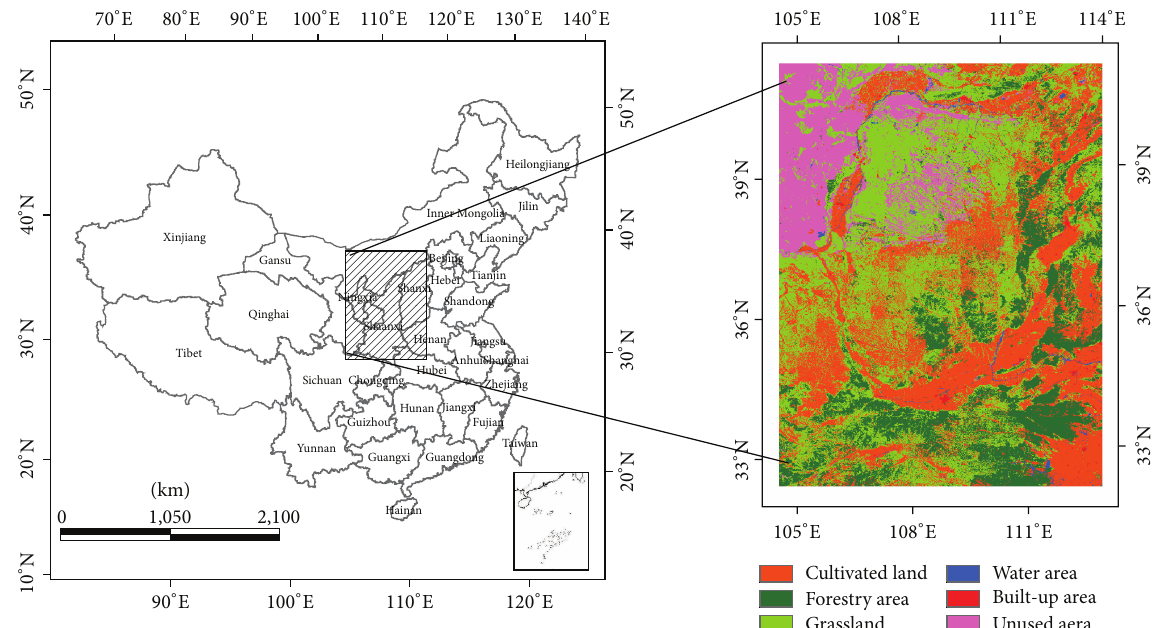
Figure 1: Location of the study area and the distribution of land use type in the overgrazing areas of Northwest China.